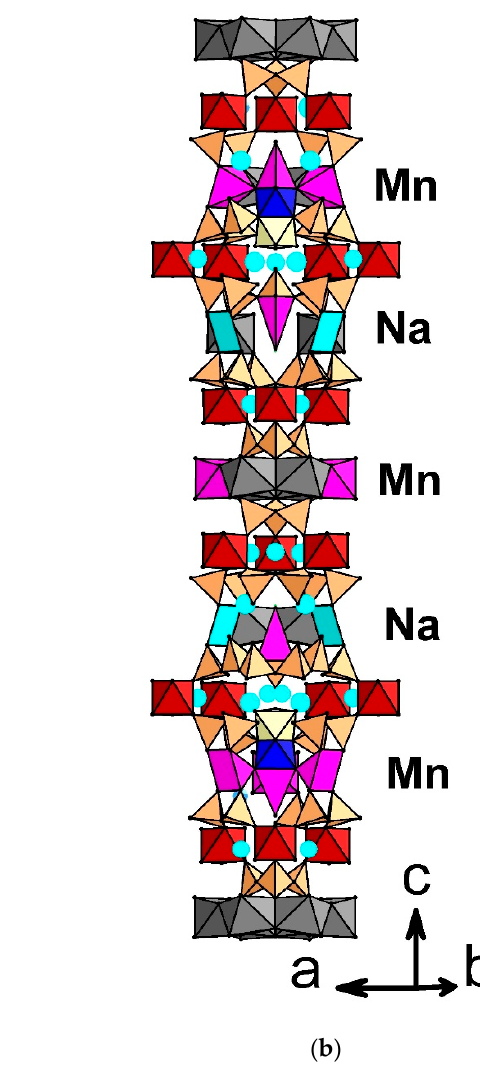
Figure 15. The crystal structures of alluaivite (differently oriented SiO 4 tetrahedra at the M 3 and M 4 sites are shown with red) ( a ) and Mn-rich “megaeudialyte” with the alteration of M 2 ( IV Na) and M 2 ( V Mn 2 + ) in neighboring modules [24] ( b ).